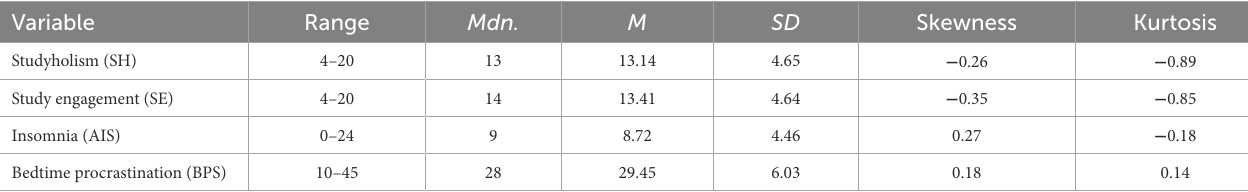
TABLE 3 Descriptive statistics ( N =